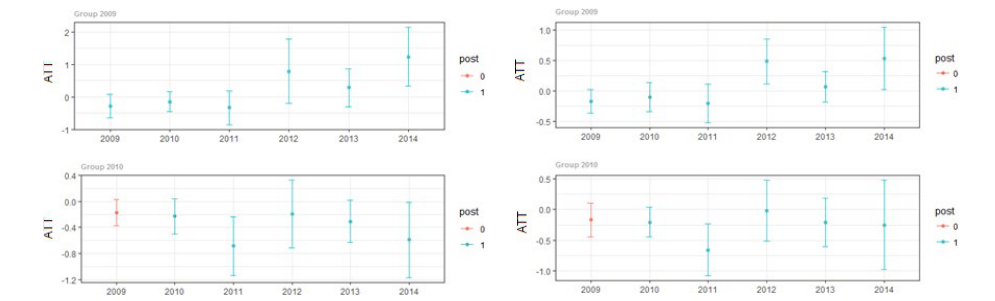
Figure 4. Group-time ATTs estimates (covariates model) – Mela Val di Non PDO sample.